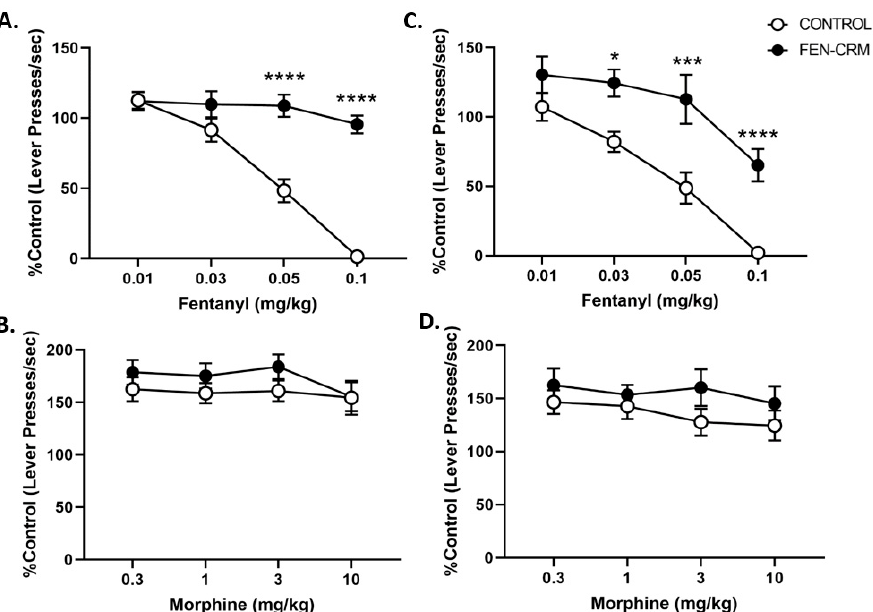
Figure 4. Effects of FEN and MOR on schedule-controlled responding in male and female Sprague Dawley rats. Rats (N = 13–14 males ( A , B ); N = 12, females ( C , D )) were trained to lever press for food under an FR15 (frequency ratio) schedule of responding. Once a rat met testing criteria, it was administered one of four doses of FEN ( A , C ) or MOR ( B , D ). Rats were then vaccinated at 0, 3 and 6 weeks and retested with both compounds between weeks 8–10 post-initial vaccination. Data are presented as mean ± SEM % control rate of responding. Vaccination significantly blocked the rate decreasing effects of FEN but did not alter the influence of MOR on response rates in both male and female rats. * p < 0.05,*** p < 0.001, **** p < 0.0001.